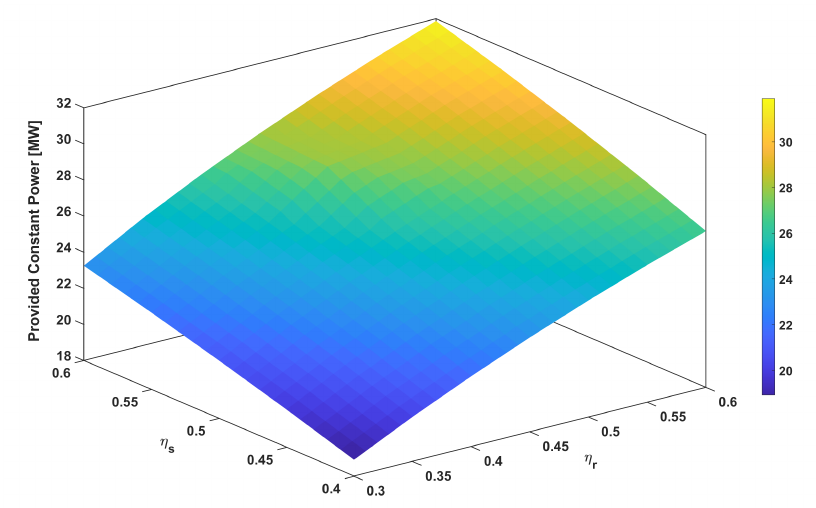
Figure 11. Sensitivity analysis of the provided constant power to both storing, η s and recovery efficiency, η r